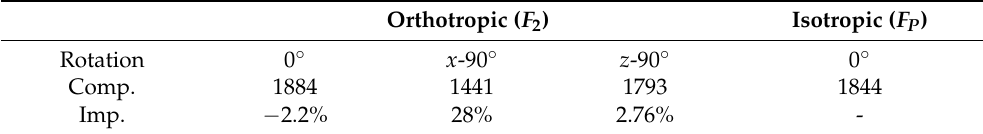
Table 3. Improvement in the structure’s stiffness by rotating the